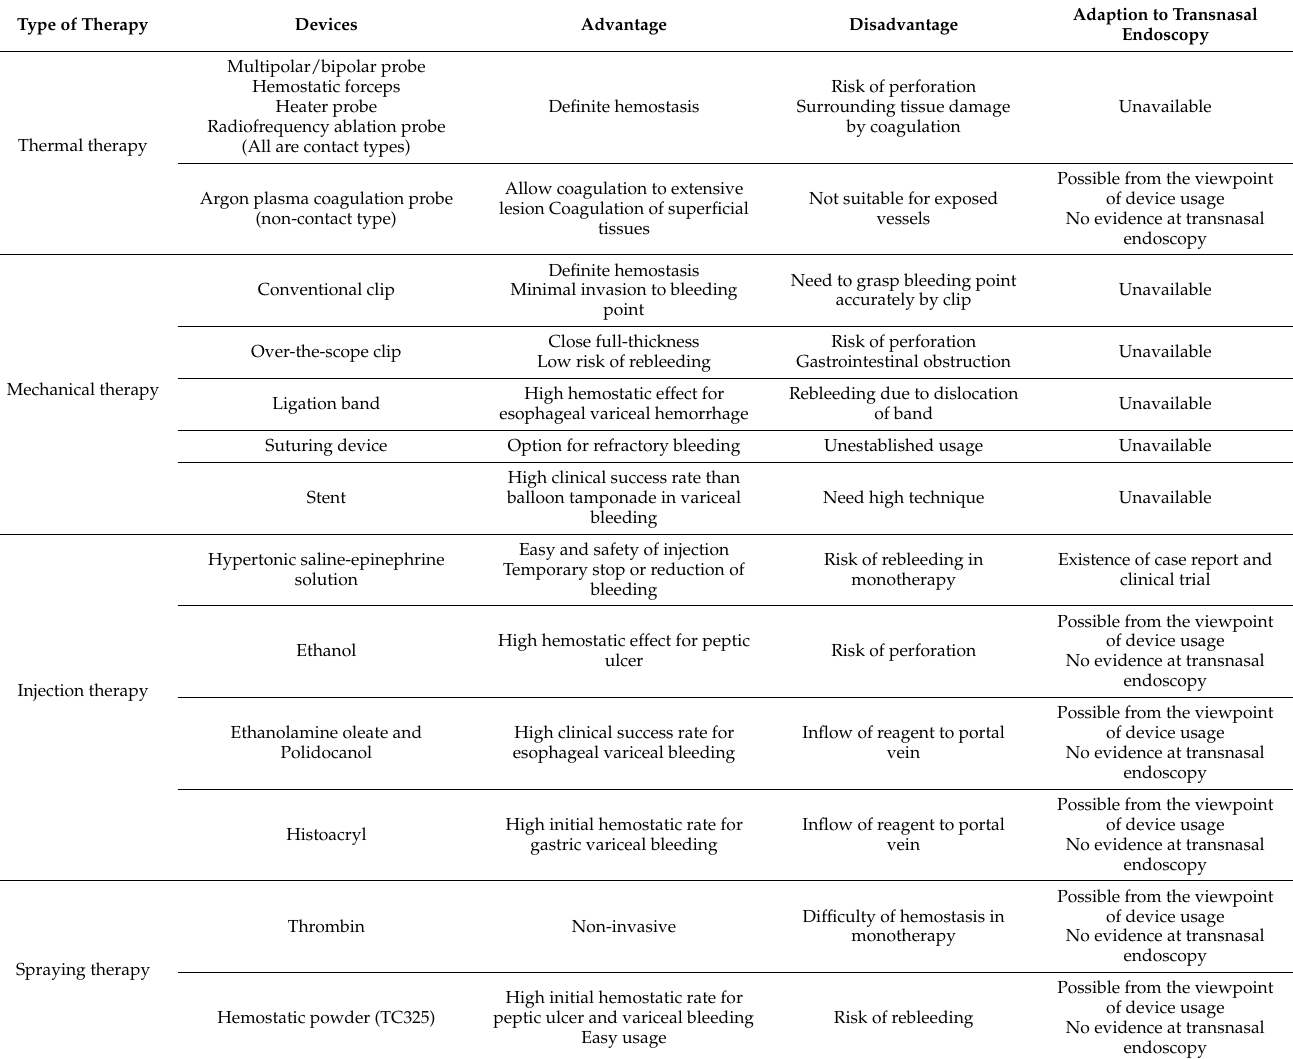
Table 1. Current devices for endoscopic therapy in